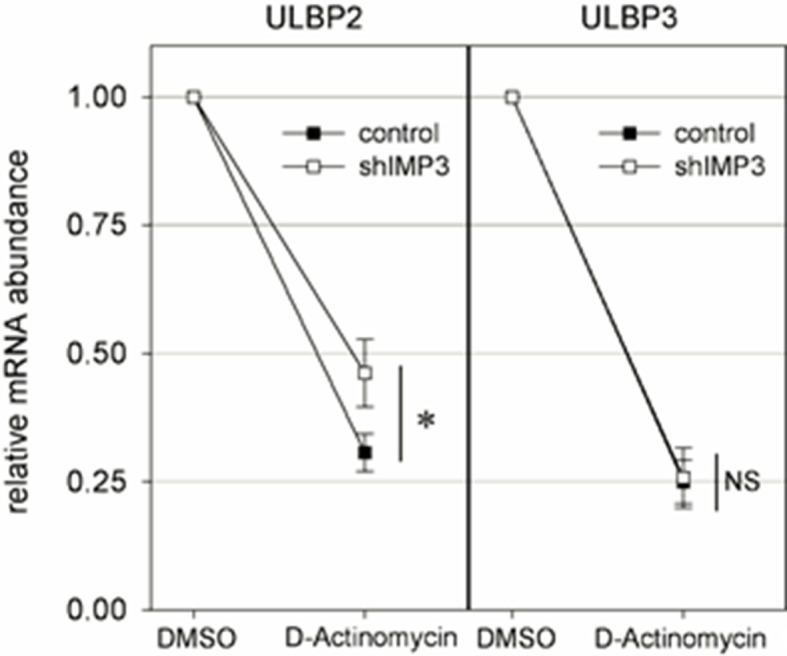
Stability determinations of mRNA transcripts of ULBP2 and 3.RKO transfected with a scrambled shRNA (control) or with shIMP3 were treated with D Actinomycin or with DMSO as control. 16 hr later, mRNAs were isolated and cDNA was prepared. The various mRNA transcripts were analyzed using qRT-PCR. Transcript levels were compared by normalization to GAPDH and by setting transcript levels determined for DMSO treatment as 1. Figure shows merged data of three replicates. *p<0.01 for ULBP2 in student’s t-test; for ULBP3, no significant differences were observed (NS).